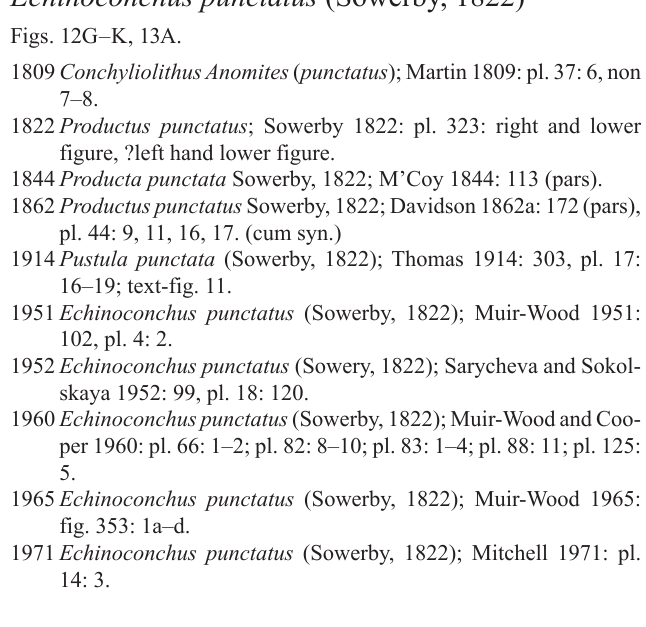
fig. 349: a–e. fig. 7: H–K. figs. 6.6, 6.7. (cum syn.) Material